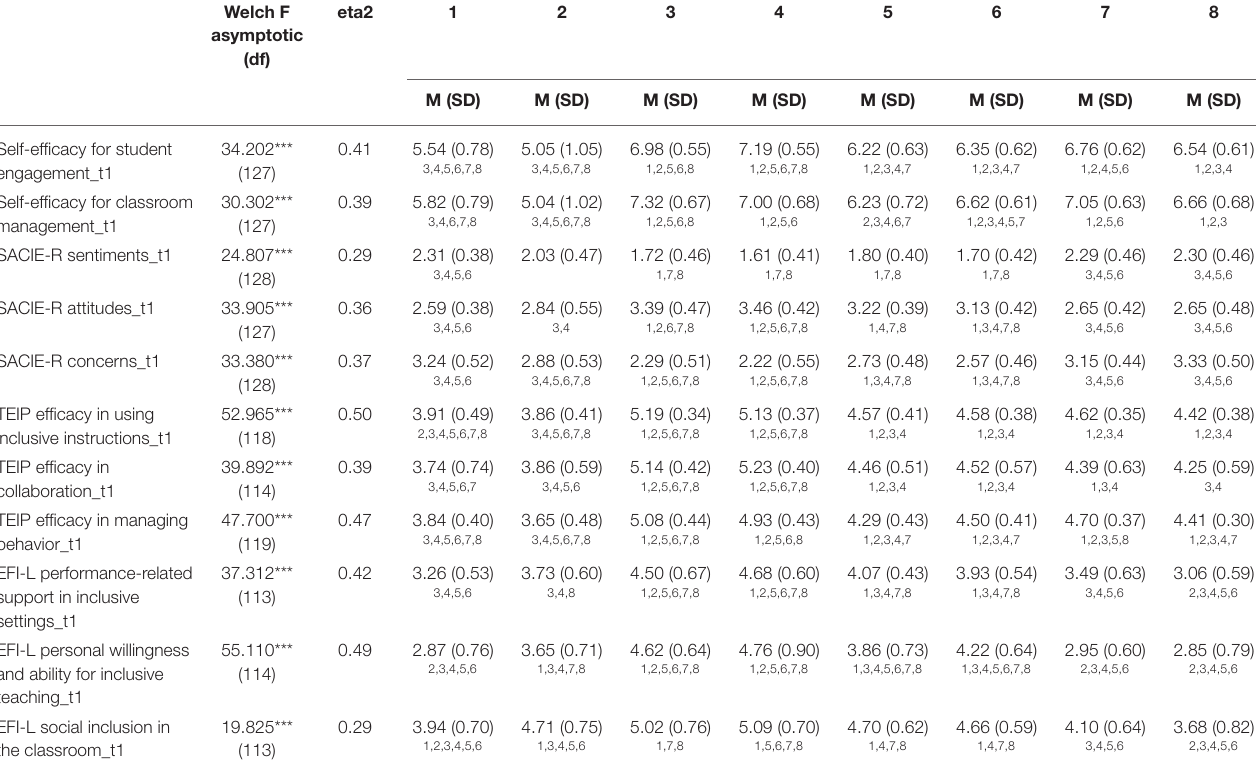
TABLE 6 | Variance analysis with the Games-Howell post-hoc test of the 11 analyzed latent profile analysis variables in the eight patterns (four classes solution) for t1 variables. Welch F